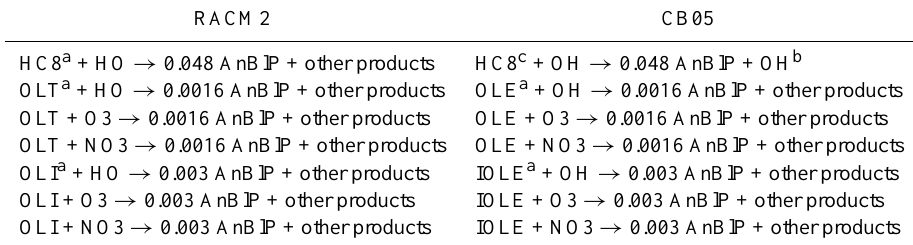
Table 3e. Biogenic alkene oxidation chemistry for SVOC formation.